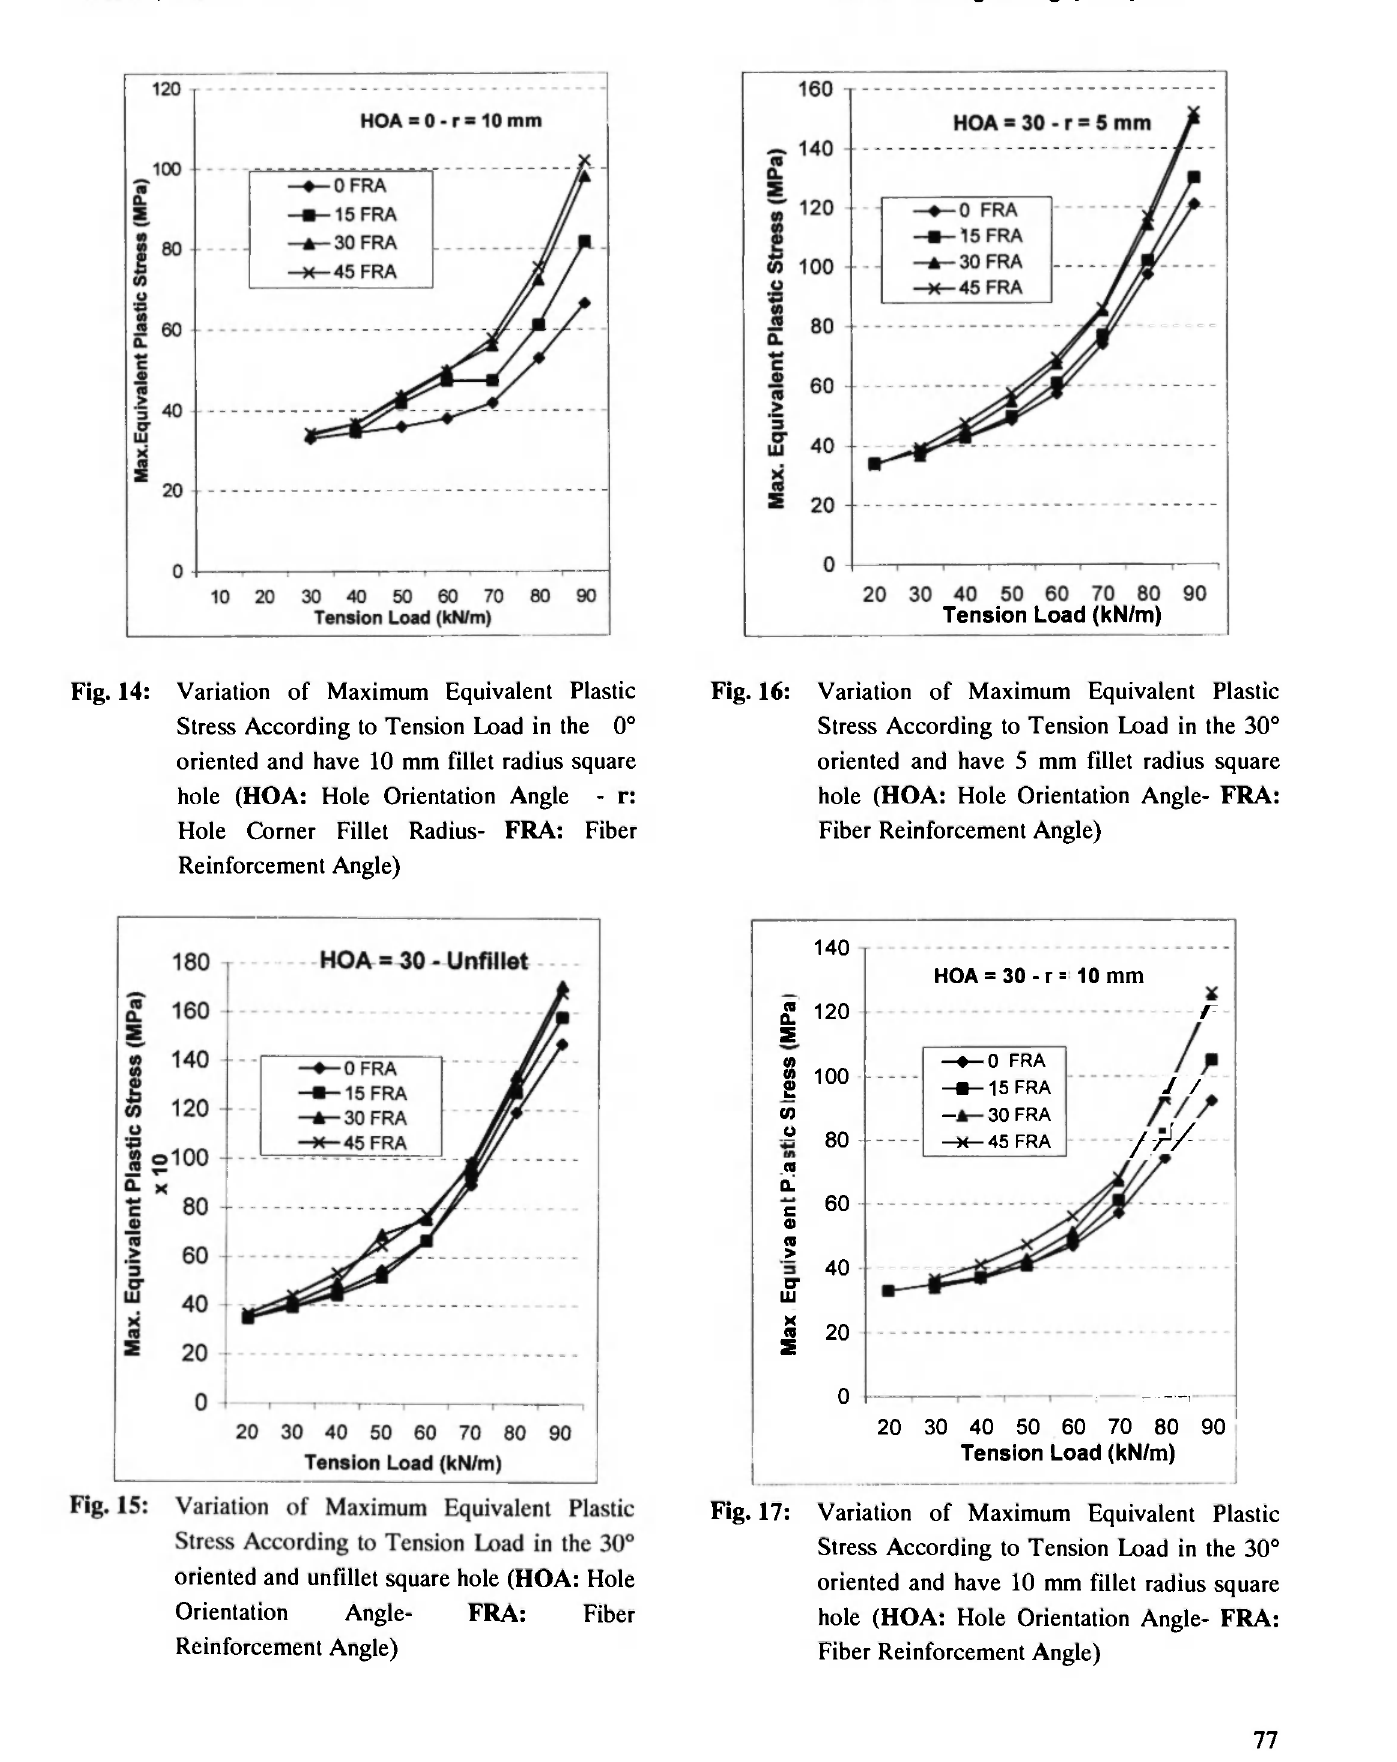
Fig. 17: Variation of Maximum Equivalent Plastic Stress According to Tension Load in the 30° oriented and have 10 mm fillet radius square hole (HOA: Hole Orientation Angle- FRA: Fiber Reinforcement